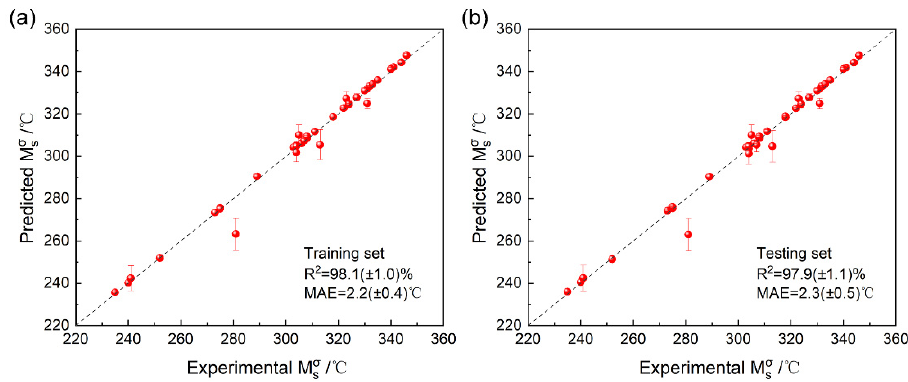
Figure 3. The performance of the proposed CNN model for M σ s prediction: ( a ) training set; ( b ) testing set.